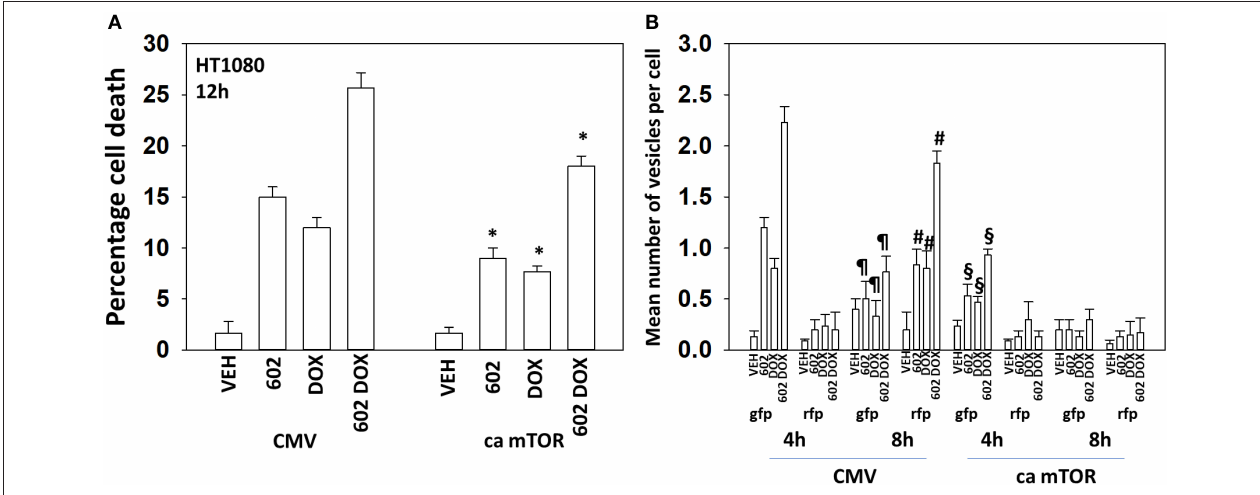
FIGURE 6 | Expression of activated mTOR suppresses tumor cell killing and abolishes autophagic flux. (A) HT1080 human sarcoma cells were transfected with an empty vector plasmid (CMV) or with a plasmid to express a mutant active mTOR protein. Twenty-four hour afterwards, cells treated with vehicle control, GZ17-6.02 (2 µ M final curcumin), doxorubicin (200nM) or the drugs in combination for 12h. Cells were isolated, and viability determined by a trypan blue exclusion assay ( n = 3 + /–SD). * p < 0.05 less than vehicle control. (B) HT1080 cells were transfected with an empty vector plasmid (CMV) or with a plasmid to express a mutant active mTOR protein and in parallel all transfected with a plasmid to express LC3-GFP-RFP. Twenty-four hour afterwards, cells treated with vehicle control, GZ17-6.02 (2 µ M final curcumin), doxorubicin (200nM) or the drugs in combination for 4 or 8h. At each time point the mean number of intense GFP + and RFP + vesicles was